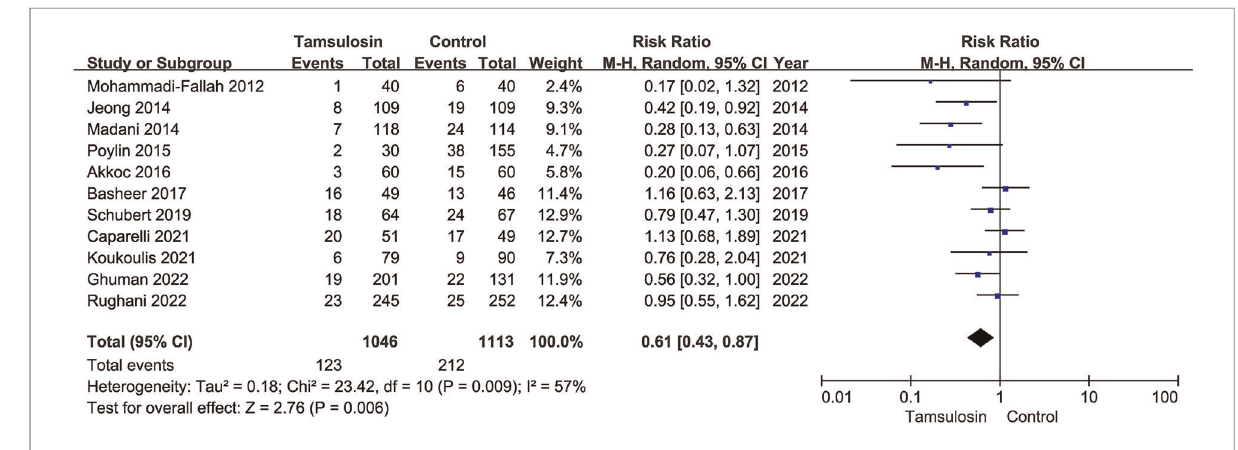
FIGURE 5 Forest plot for the rate of